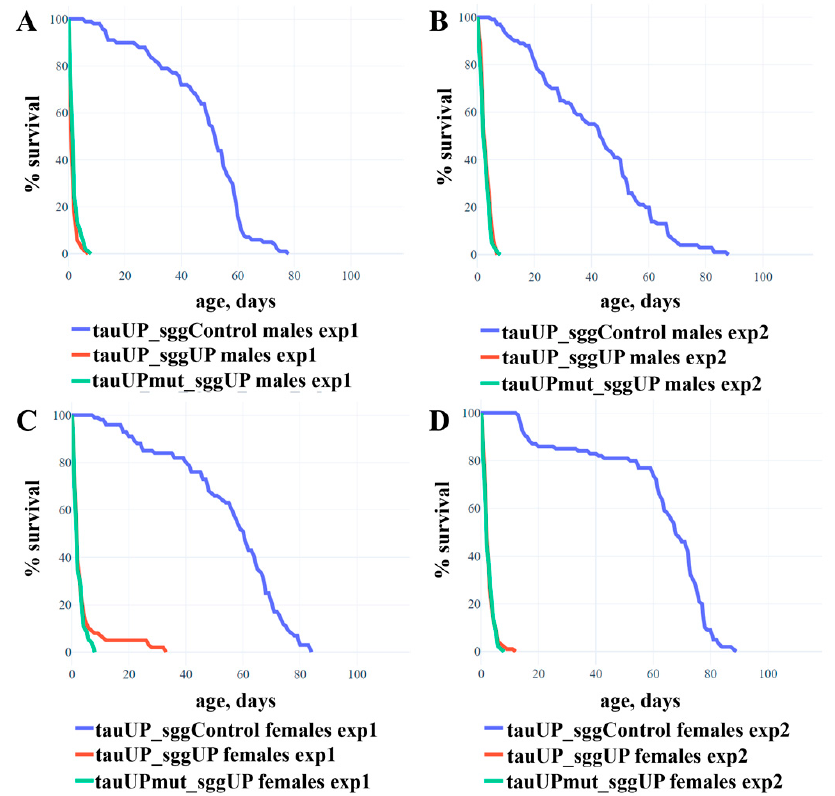
Figure 2. Co-activation of transgenes that increase the expression of the normal or mutant RA transcript of the tau gene and the RB transcript of the shaggy gene reduces the lifespan of males and females. ( A , B )—Experiments 1 and 2 with males. ( C , D )—Experiments 1 and 2 with females. A detailed description of the genotypes is given in the Materials and Methods section. Statistical analysis of the data is given in the Supplementary Materials Table S2.